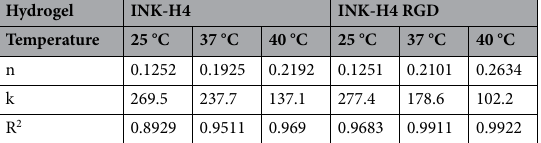
Table 1. Flow index and consistency index of Inks H4 and Ink H4-RGD at 25 °C, 37 °C and 40 °C.